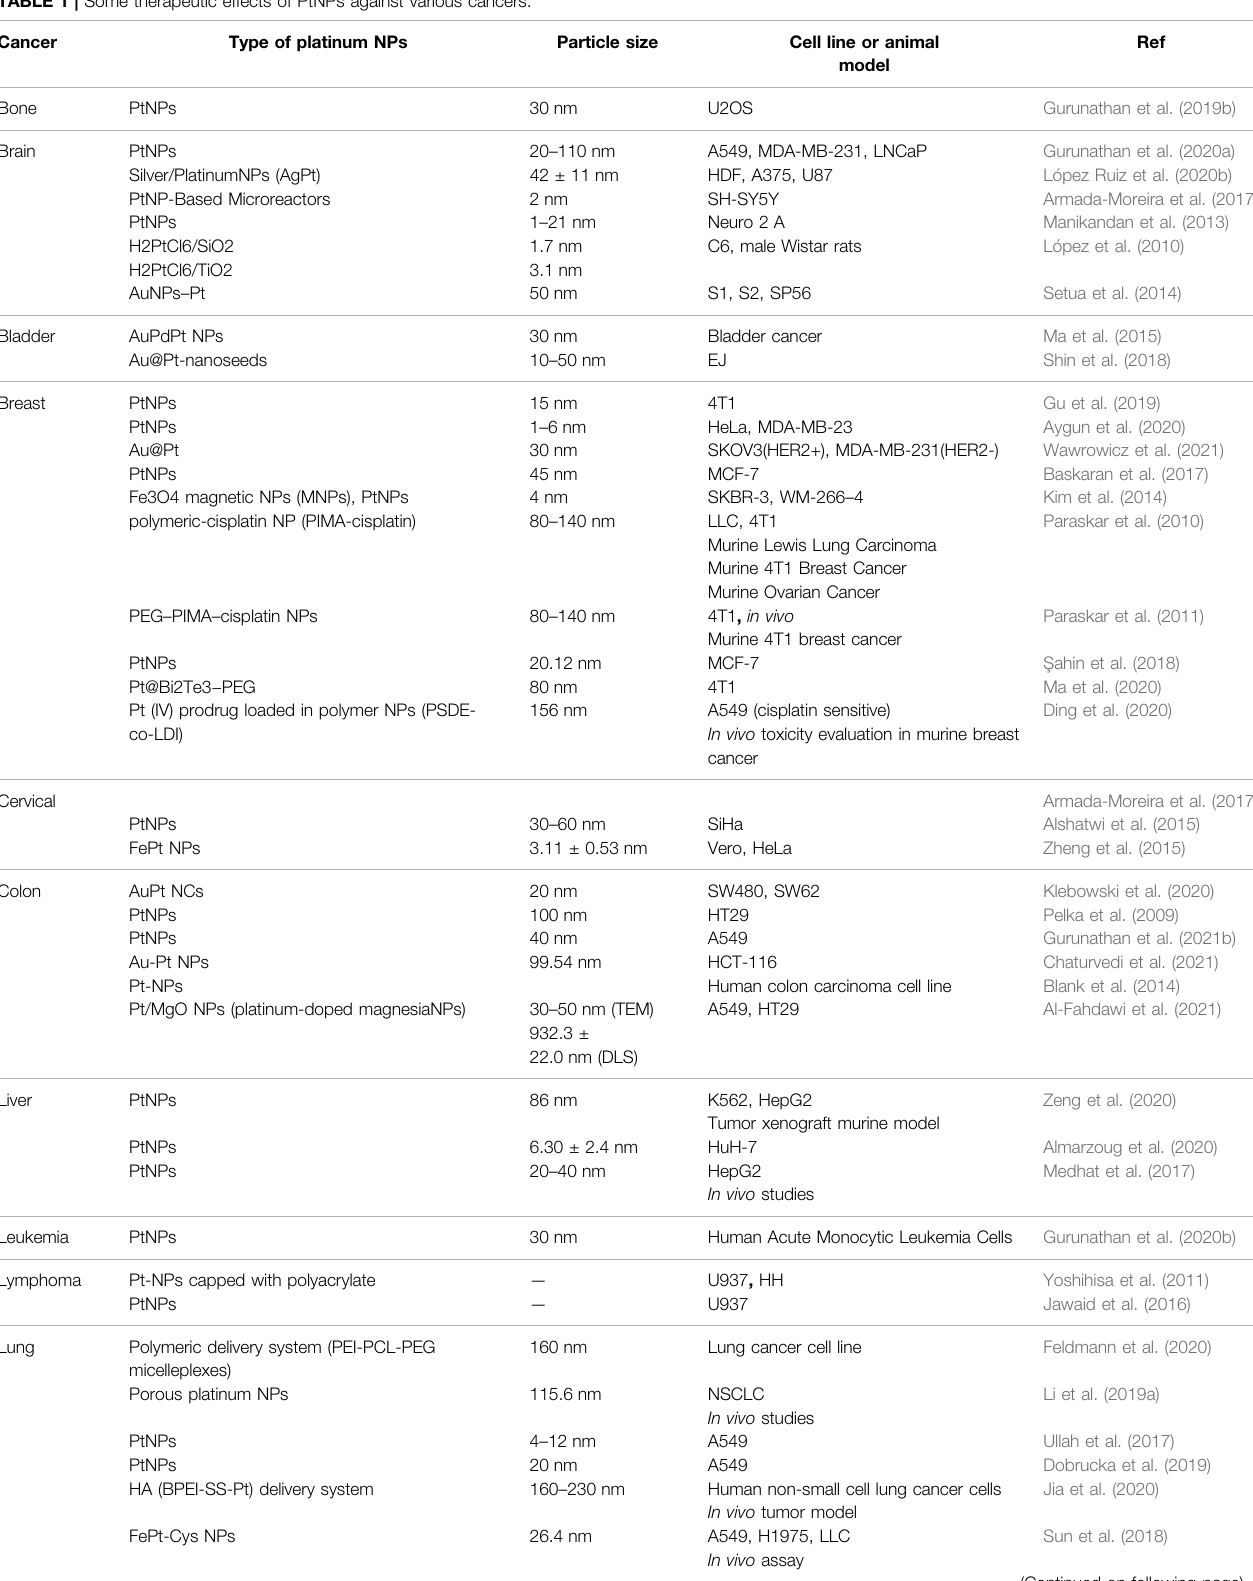
TABLE 1 | Some therapeutic effects of PtNPs against various